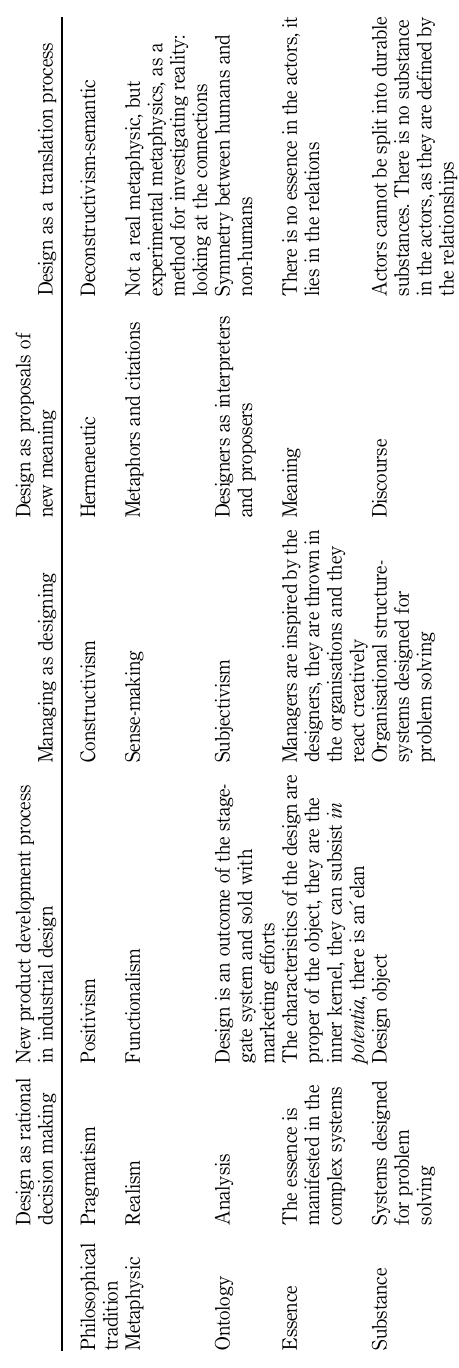
analysis of the